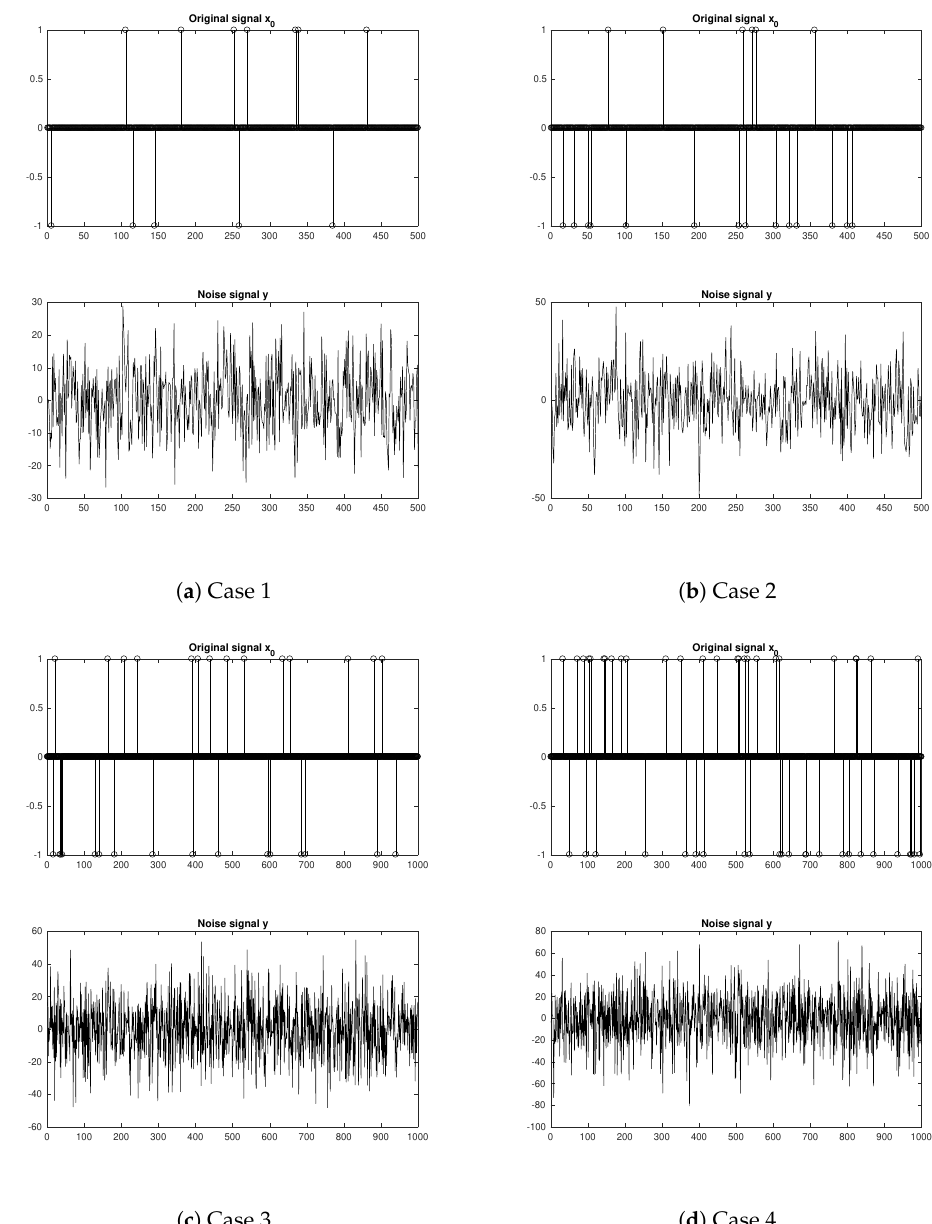
Figure 8. Original and noise signals in various dimentions N and sparsities k in Example